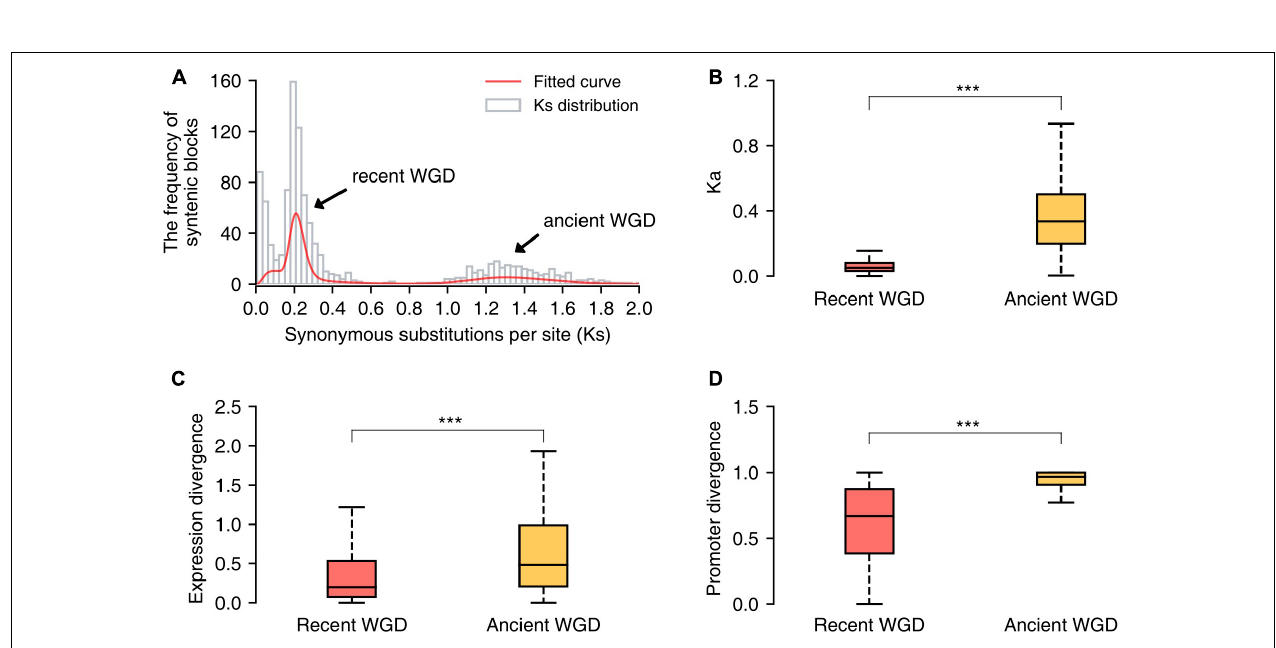
FIGURE 6 | The comparison of sequence, expression and promoter divergence between duplicated genes derived from recent and ancient whole-genome duplications (WGD) events. (A) The distribution of K s values of syntenic/paralogous blocks within the pear genome. (B) The comparison of sequence divergence between duplicated genes from two different WGD events. (C) The comparison of expression divergence between duplicate genes from two different WGD events. (D) The comparison of promoter divergence between duplicate genes from two different WGD events. Significant differences (Mann–Whitney U test): ∗∗∗ P < 0.001.